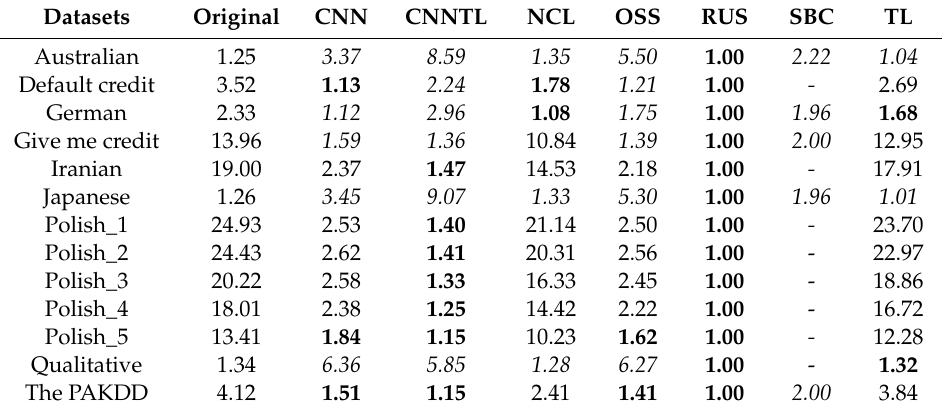
Table 7. Imbalance ratio for undersampling algorithms.